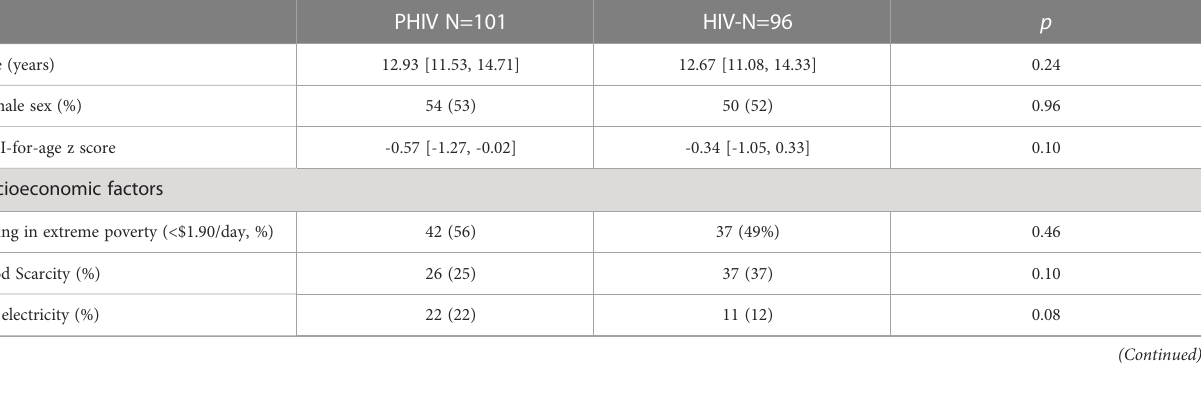
TABLE 1 Baseline